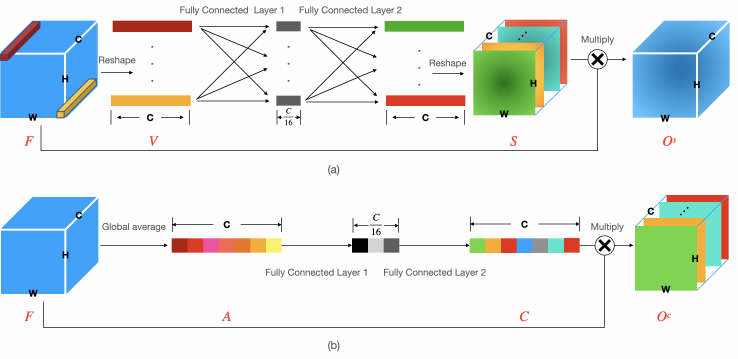
Figure 5. Attention modules. ( a ) Spatial attention. ( b ) Channel